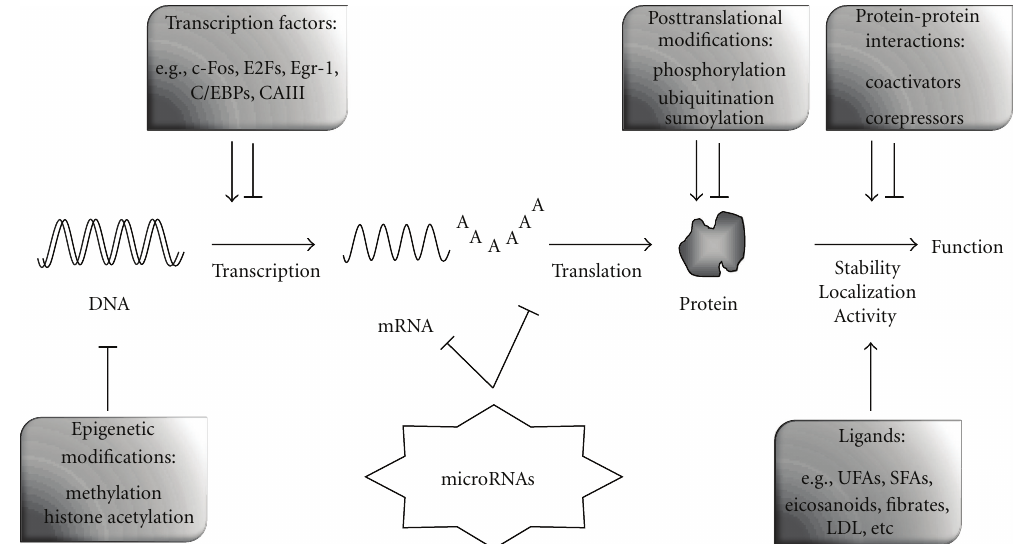
Figure 1: Regulation of PPARs expression and activity. The scheme presents distinct mechanisms reported to regulate the expression and activity of specific PPARs isoforms. Epigenetic mechanisms, including DNA methylation and histone acetylation, may restrict the PPARs promoter activity and several transcription factors have been described to modulate either positively or negatively the transcription of distinct PPARs. As well, posttranslational modifications at the protein level ( phosphorylation, ubiquitination, and sumoylation ) and interactions with coactivators (e.g., CBP/p300, SRC-1, PGC1 α ) or corepressors (e.g., RIP-140 α , SMRT α ) regulate the transcriptional activity, localization, and stability of PPARs isoforms. miRNAs represent a new recently described class of regulators of PPARs transcriptional activity by exerting a control on PPARs mRNA degradation and